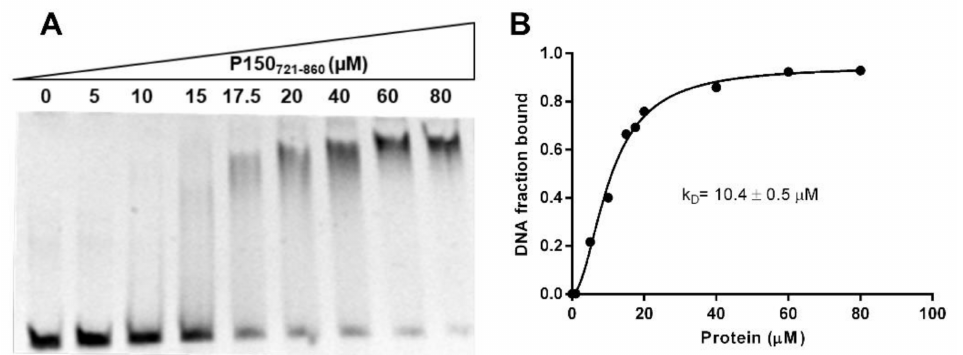
Figure 4. DNA binding ability of P150 721–860 to 58 bp dsDNA assessed by EMSA. ( A ) 1 µ M 58 bp dsDNA was incubated with increasing concentration of P150 721–860 . Gel was stained with Sybr Gold prior to visualization with UV light. ( B ) The density value of each band quantified by ImageJ was analyzed by Graph Pad-Prism, Version